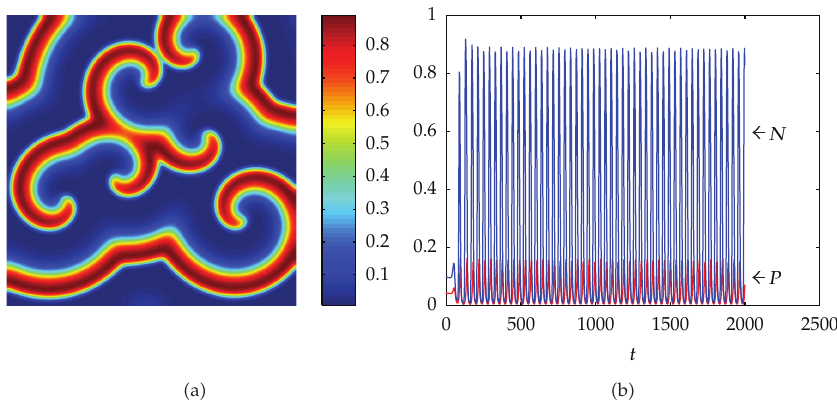
Figure 4: Dynamical behaviors of model (cid:7) 2.5 (cid:8) with the parameters: α (cid:5) 2 . 5, β (cid:5) 1 . 3, γ (cid:5) 1 . 1, d 11 (cid:5) 0 . 7, d 12 (cid:5) 0 . 05, d 21 (cid:5) 0 . 01, d 22 (cid:5) 1 at t (cid:5) 2000. (cid:7) a (cid:8) Spiral pattern. (cid:7) b (cid:8) Time-series plots.